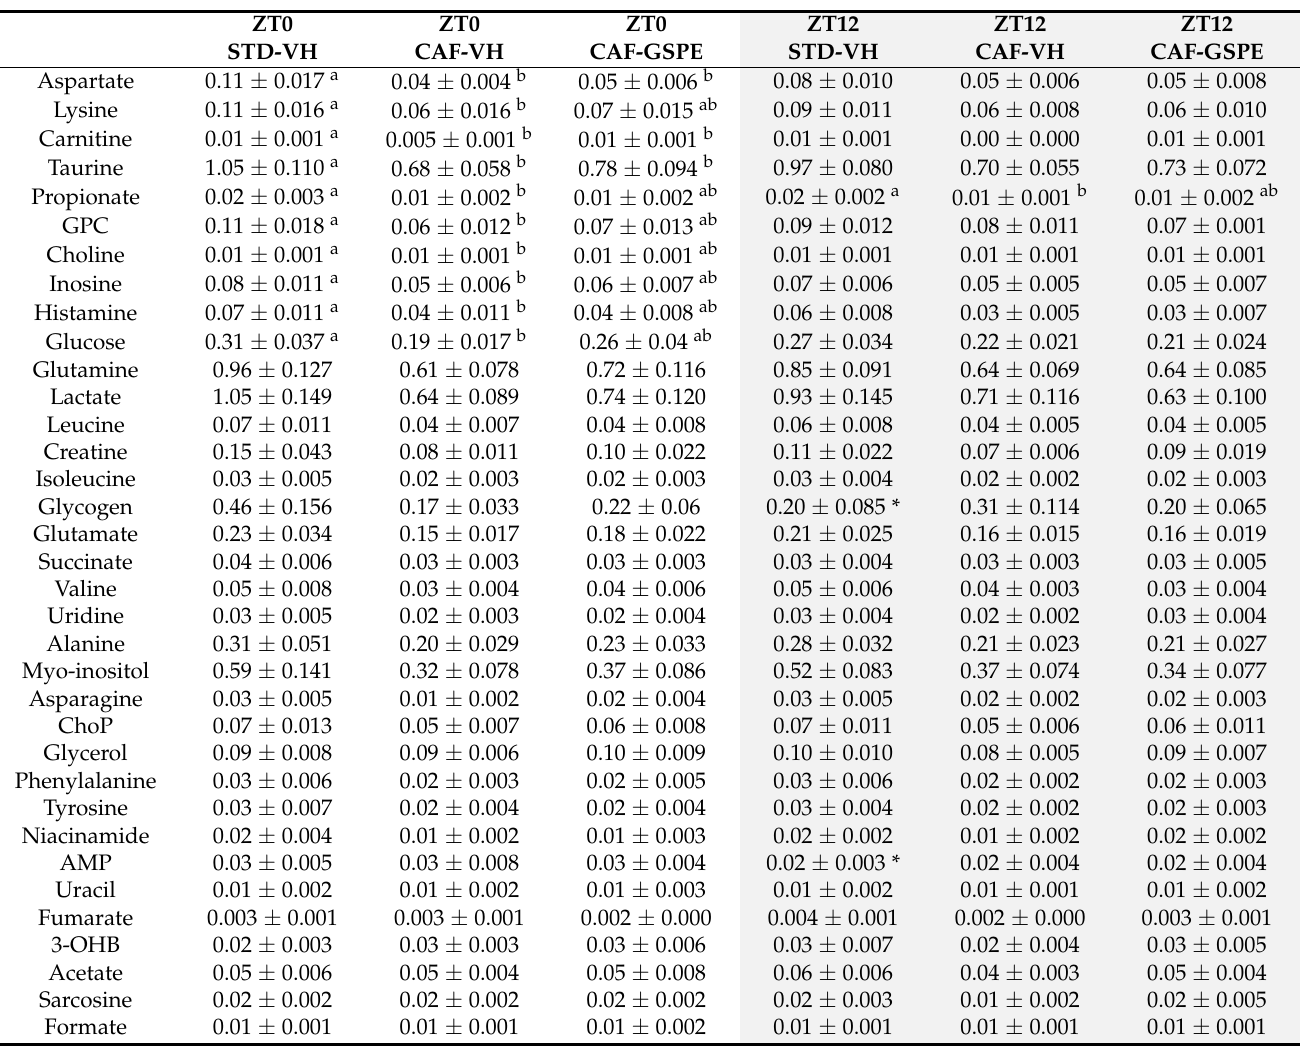
Table 4. Daily (24 h mean) concentrations ( µ mol/g) of individual hydrophilic metabolites identified in